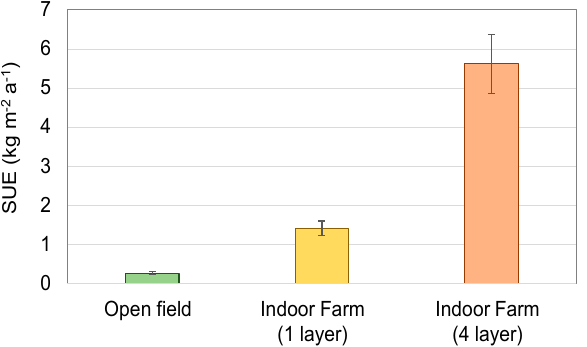
Figure 9. Land surface use efficiency (SUE) for marjoram plants grown on open field and in an indoor vertical farm with the reference value of one square meter floor area. n = 36.